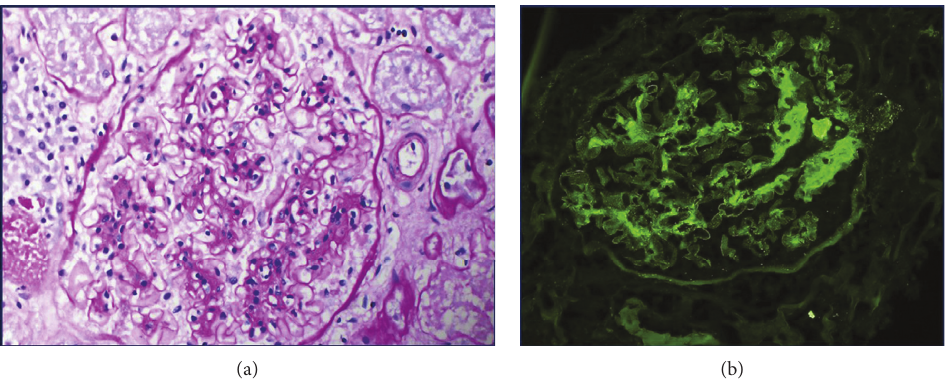
Figure 3: Renal glomeruli showing mesangioproliferative glomerulitis (a) and immunofluorescence evidence of C1q (b) and similar IgG (not shown) deposition (panel a, periodic acid-Schiff stain, magnification, 20x; panel b, immunofluorescence stain, magnification,